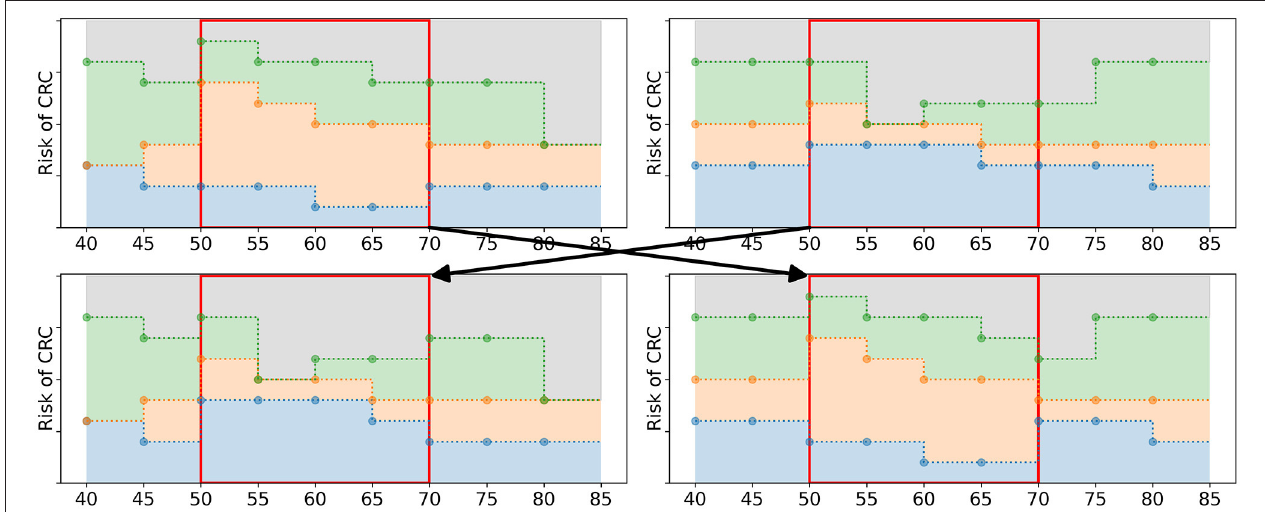
FIGURE 5 | Schematic overview of the cross-over operator. The two upper figures represent the parent policies, a random pair of policies in M g . The lower figures represent two offspring policies that are added to O g . The two age groups 50 and 65 were randomly selected. The policy bounds in between these age groups (marked by the red box) are exchanged in the